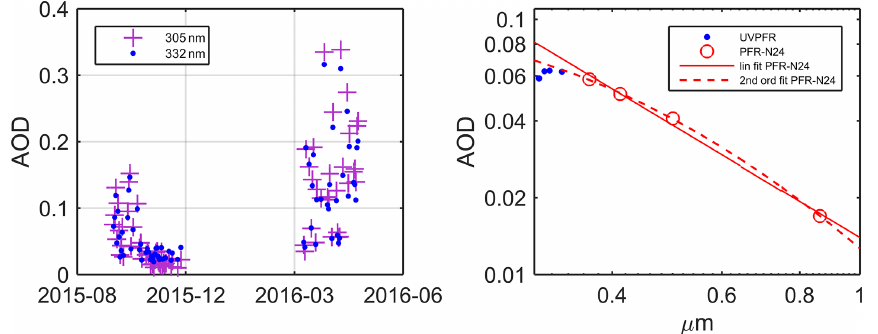
Figure 6. Daily mean AOD at 305 and 332nm in Davos (left) and mean of daily means of AOD during the whole study from the UVPFR and a standard PFR